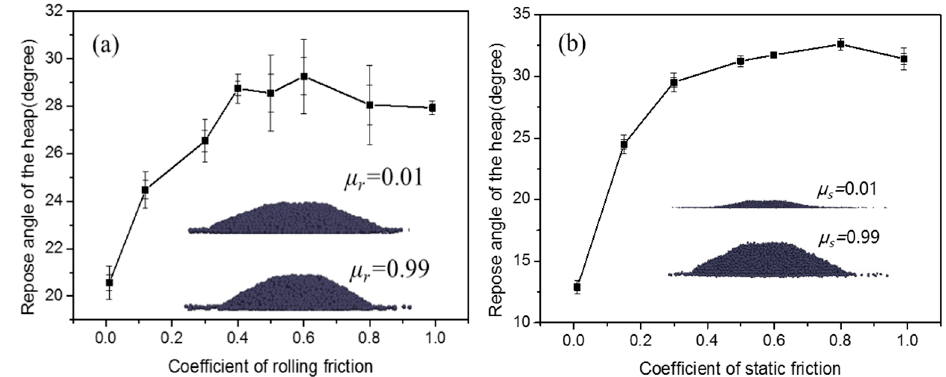
Figure 5. Relationship of the angle of repose of pellet piles and ( a ) rolling friction coefficient with 𝜇 = 0.15 , and ( b ) static friction coefficient with 𝜇 = 0.12 . Error bars indicate the deviation of the angle of repose in different directions of the pile.